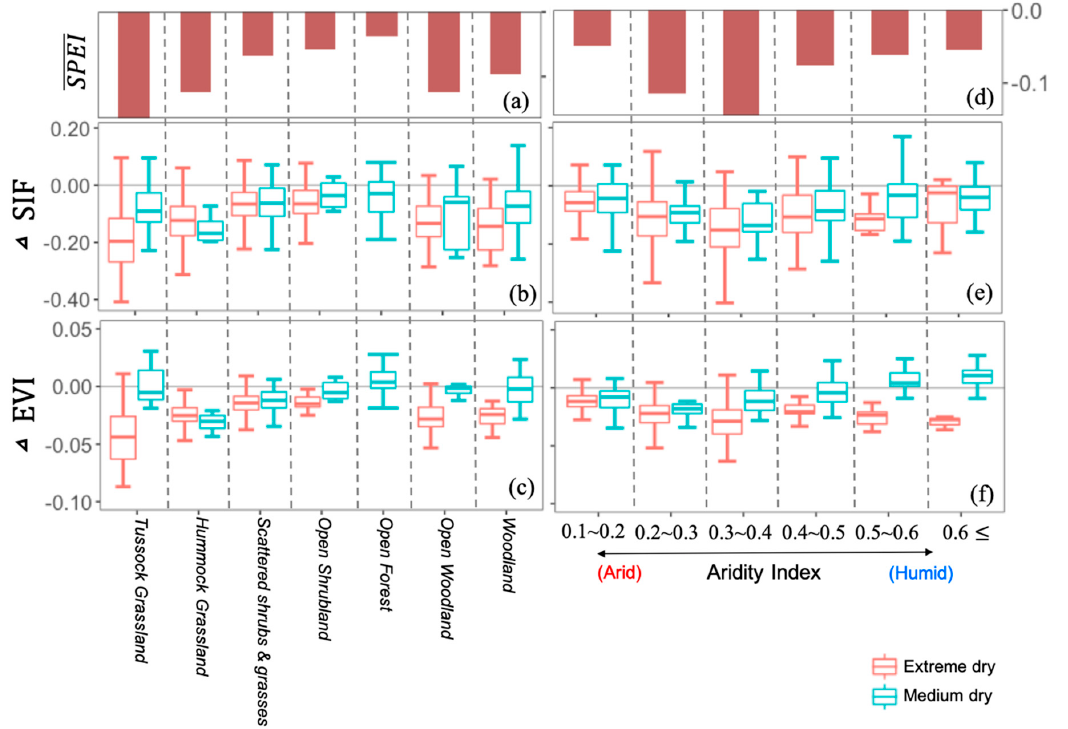
Figure 7. Boxplot of anomalies of EVI and SIF under extreme and medium dry in 2018–2019 grouped by ( b , c ) major biome types and ( e , f ) aridity index. ( a , d ) The top panel refers to the spatially mean SPEI of each category.